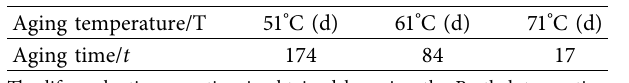
Figure 7: Life fitting curve. Table 8: Aging time to failure critical point under different aging